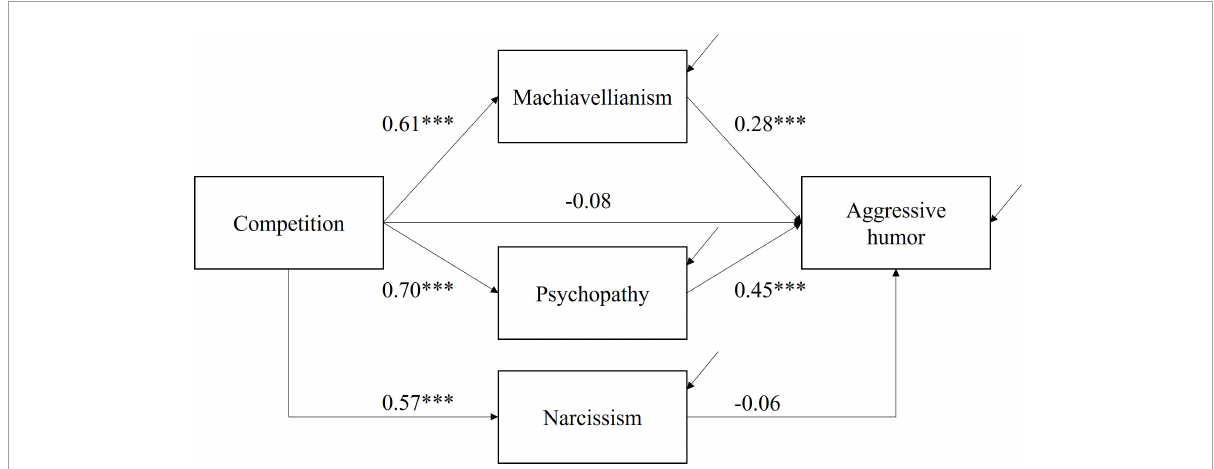
FIGURE2 Indirect effects of Machiavellianism and psychopathy. Arrow lines pointing toward Machiavellianism, psychopathy, narcissism, and aggressive humor represent residual terms. The covariances of the residual terms of the mediators (i.e., Machiavellianism, psychopathy, and narcissism) were controlled for in model estimation but omitted in the figure for clarity of presentation. ∗∗∗ p < 0.001.